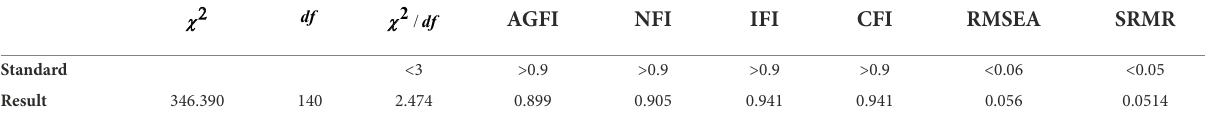
TABLE 5 Initial model fit